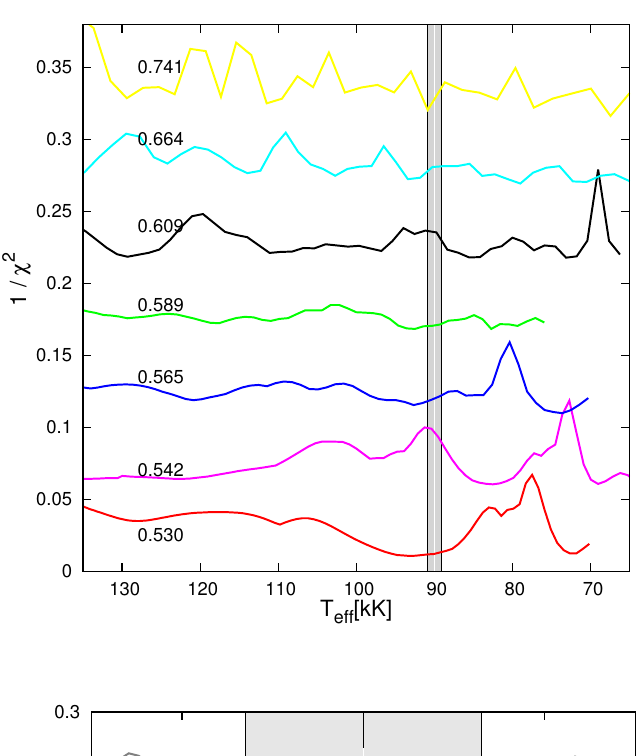
Figure 3. Same as Figure 2 but for VV47, for the case “before the knee”. The curves have been arbitrarily shifted upward for clarity (with a step of